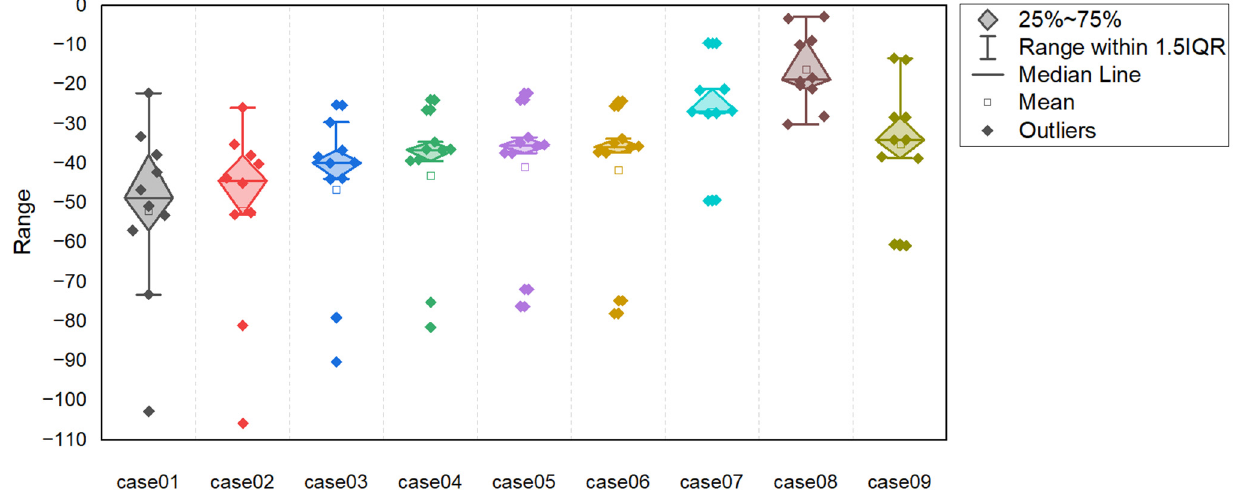
Figure 18. Comprehensive energy-saving potential comparison between different PVSDs.